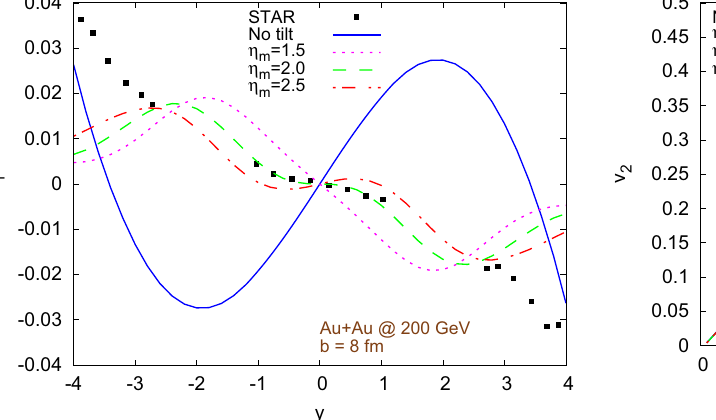
√ s NN = 2 . 76TeV at τ 0 = 0 .